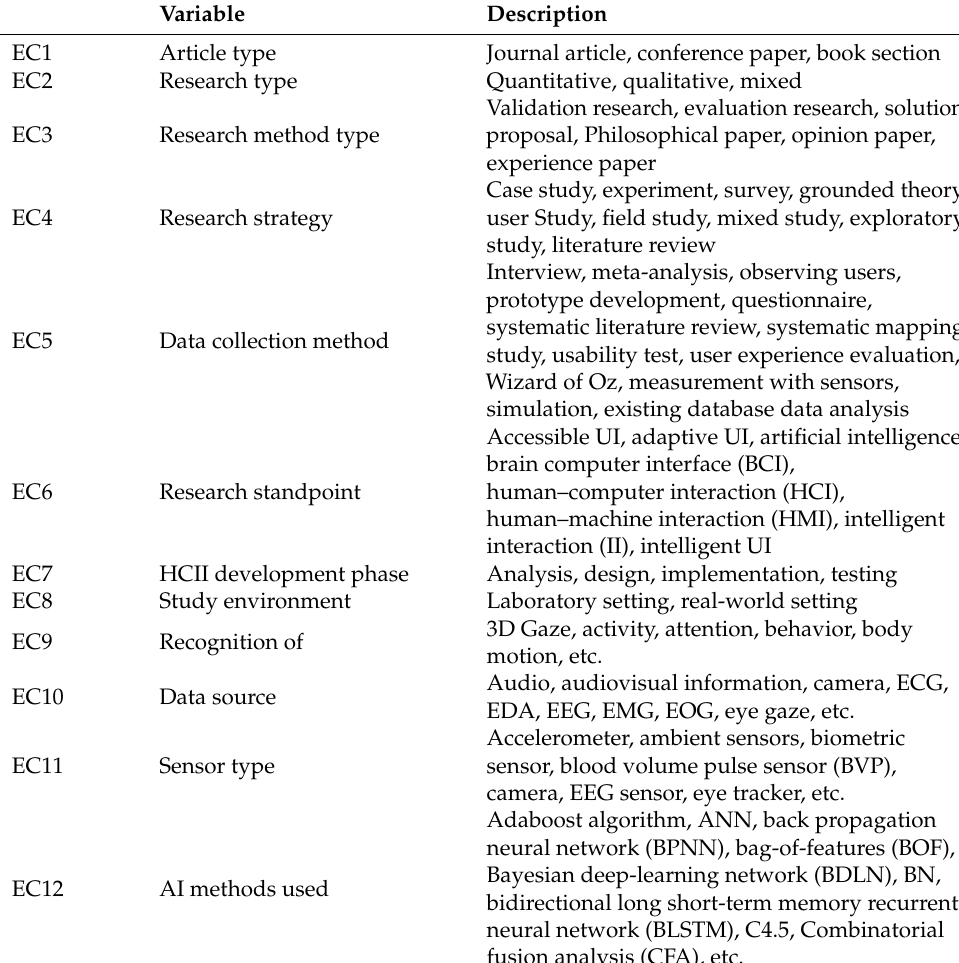
Table 5. Coding and classification